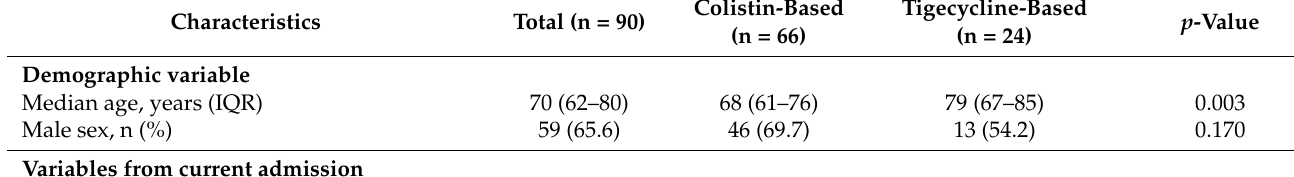
Table 1. Comparison of demographic and clinical characteristics between the meropenem–colistin and